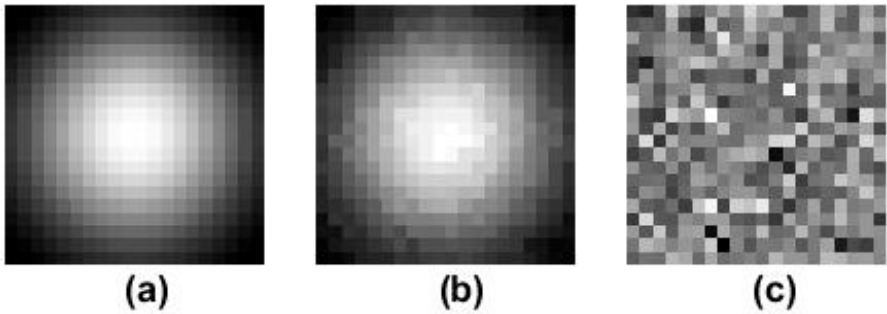
Figure 5. Results of the point spread function in Figure 1 (SNR = 40 dB, Sampling Ratio = 0.8). ( a ) the point spread function; ( b ) the estimated point spread function; ( c ) the difference between point spread function and the estimated point spread function.